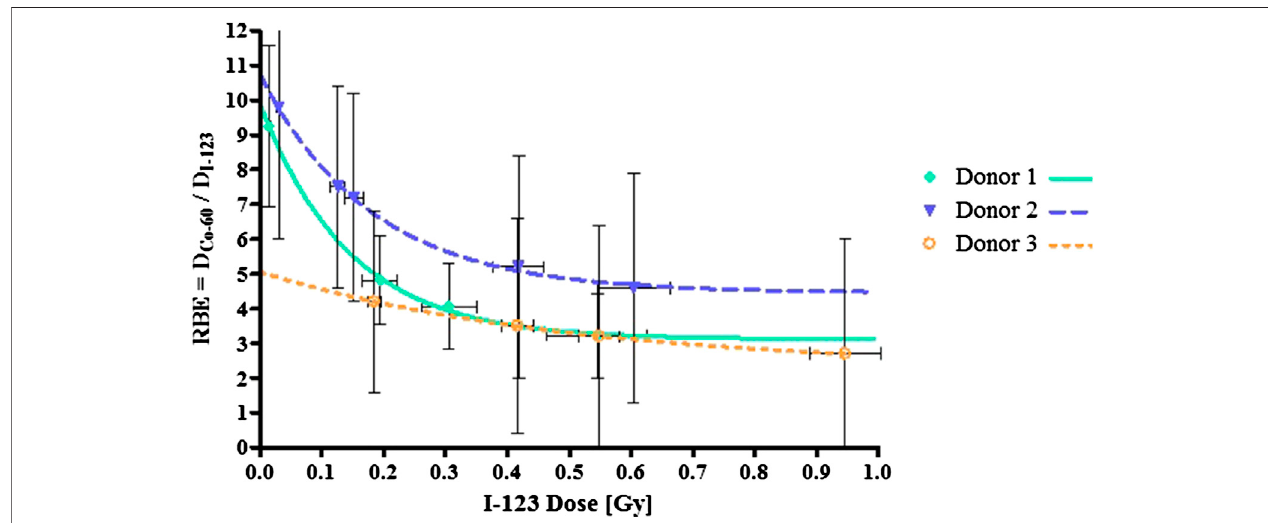
FIGURE5| RBEvaluesbased onthedatapoints inthelinear regionofthe 123 Idose-response curves foreach donor. Theerror barsare thestandarddeviationsof the mean RBE per dose point.